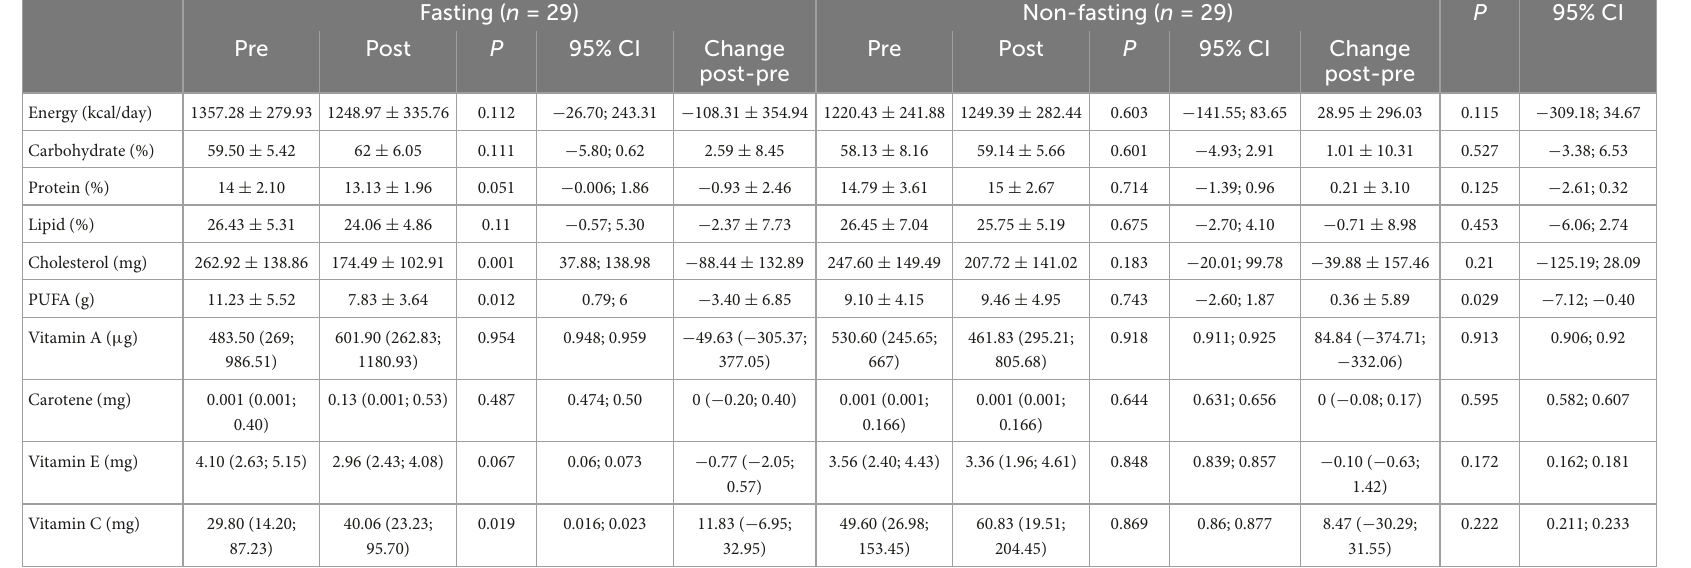
TABLE 2 Changes in calorie, macronutrient, and antioxidant intake after 2